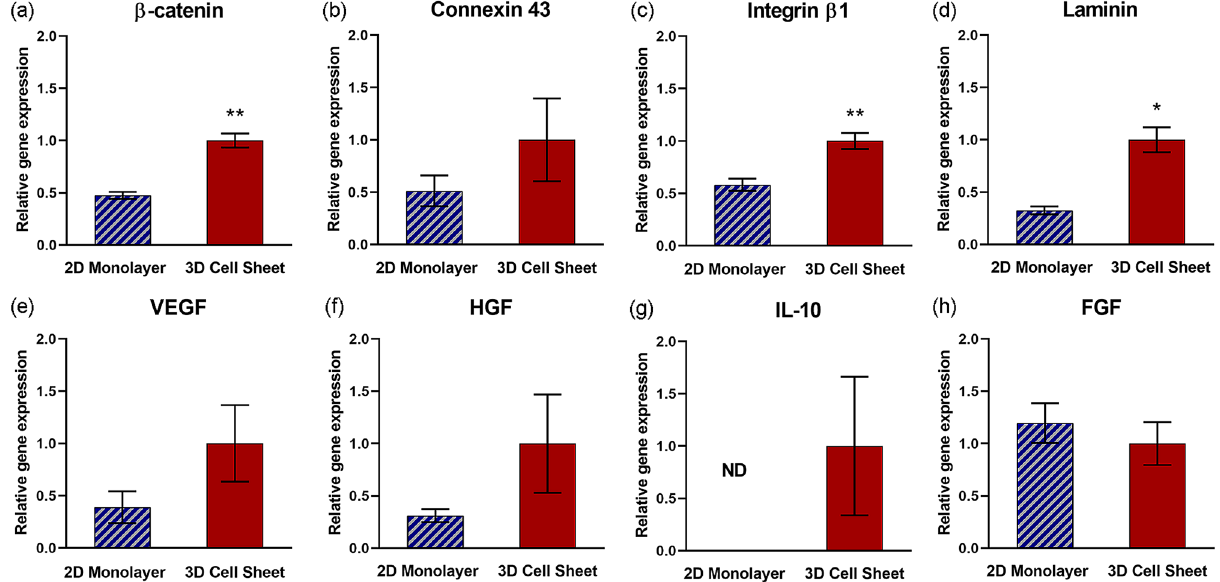
Figure 4. Enhanced pro-regenerative cytokine gene expression related to 3D cell sheet tissue-like structure. Quantitative gene expression of proteins related to tissue-like interactions, including ( a ) β-catenin (cell–cell interaction), ( b ) connexin 43 (gap junction), ( c ) integrin β1 (cell–ECM interaction), and ( d ) laminin (ECM), were increased per hUC-MSC in 3D cell sheets relative to 2D monolayers. Quantitative gene expression of pro- regenerative cytokines ( e ) VEGF, ( f ) HGF, and ( g ) IL-10 also increased per hUC-MSC in 3D cell sheets relative to 2D monolayers, with undetectable levels of IL-10 expression in hUC-MSCs in 2D monolayers. ( h ) FGF gene expression was similar in MSC 2D monolayer and 3D MSC sheets. Values are means ± SE (n = 3: * p < 0.05, ** p < 0.01). ND not determined.